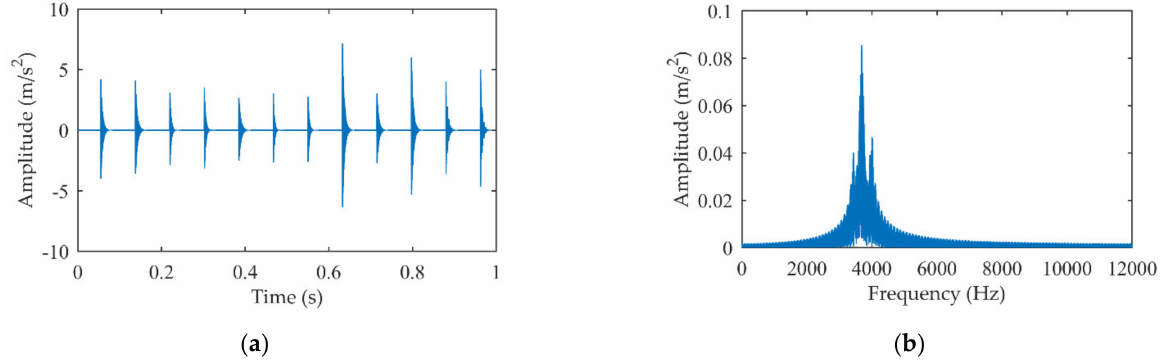
Figure 10. The extracted impact signal by proposed method: ( a ) Time domain signal; ( b ) Amplitude spectrum.